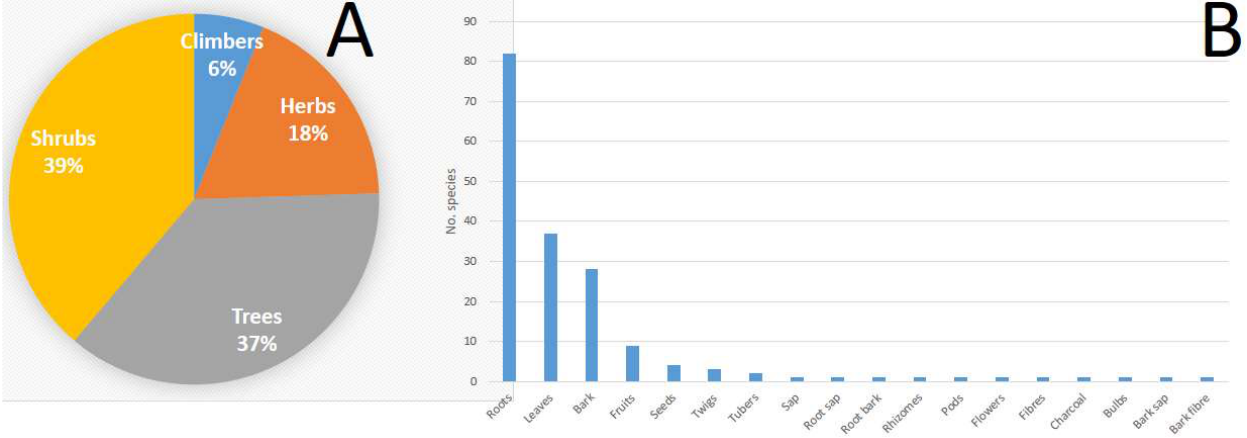
Figure 3. Characteristics of Fabaceae species used as traditional medicines in Zimbabwe. ( A ): Growth habit as a pie diagram and ( B ): Plant parts used presented as a bar chart.